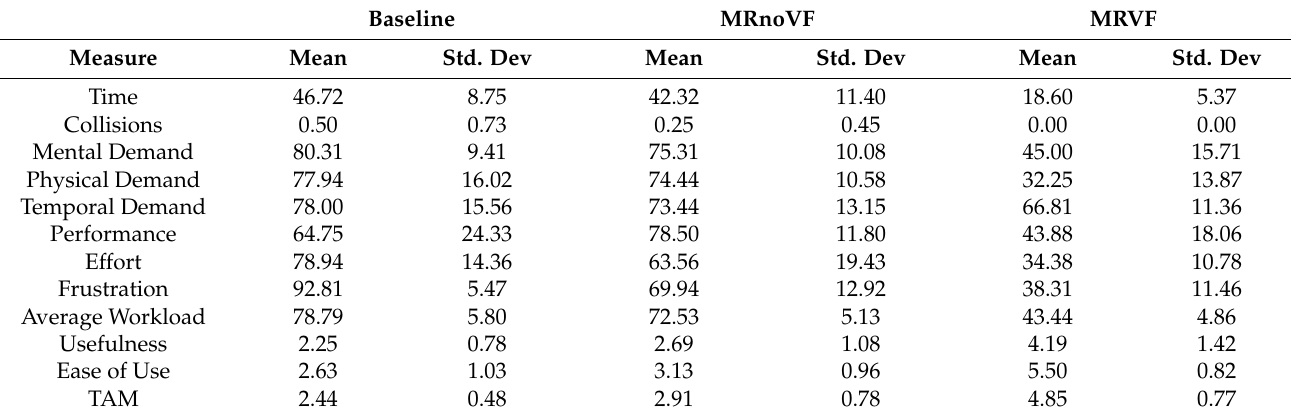
Table 3. Statistical p -values for all quantitative metrics, where B = baseline and MR = MRnoVF.